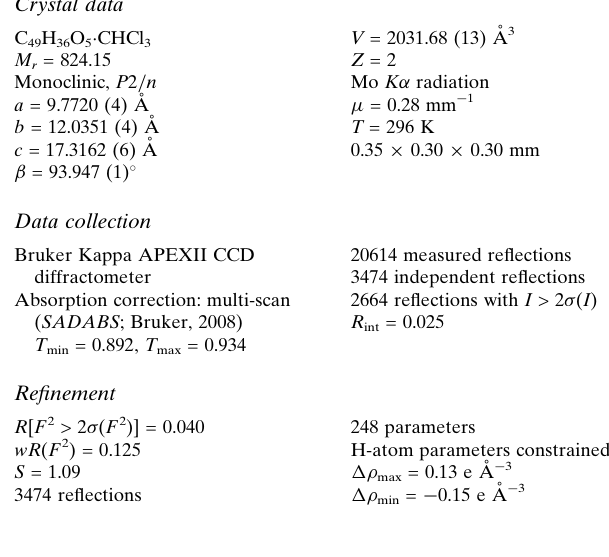
Experimental Crystal data